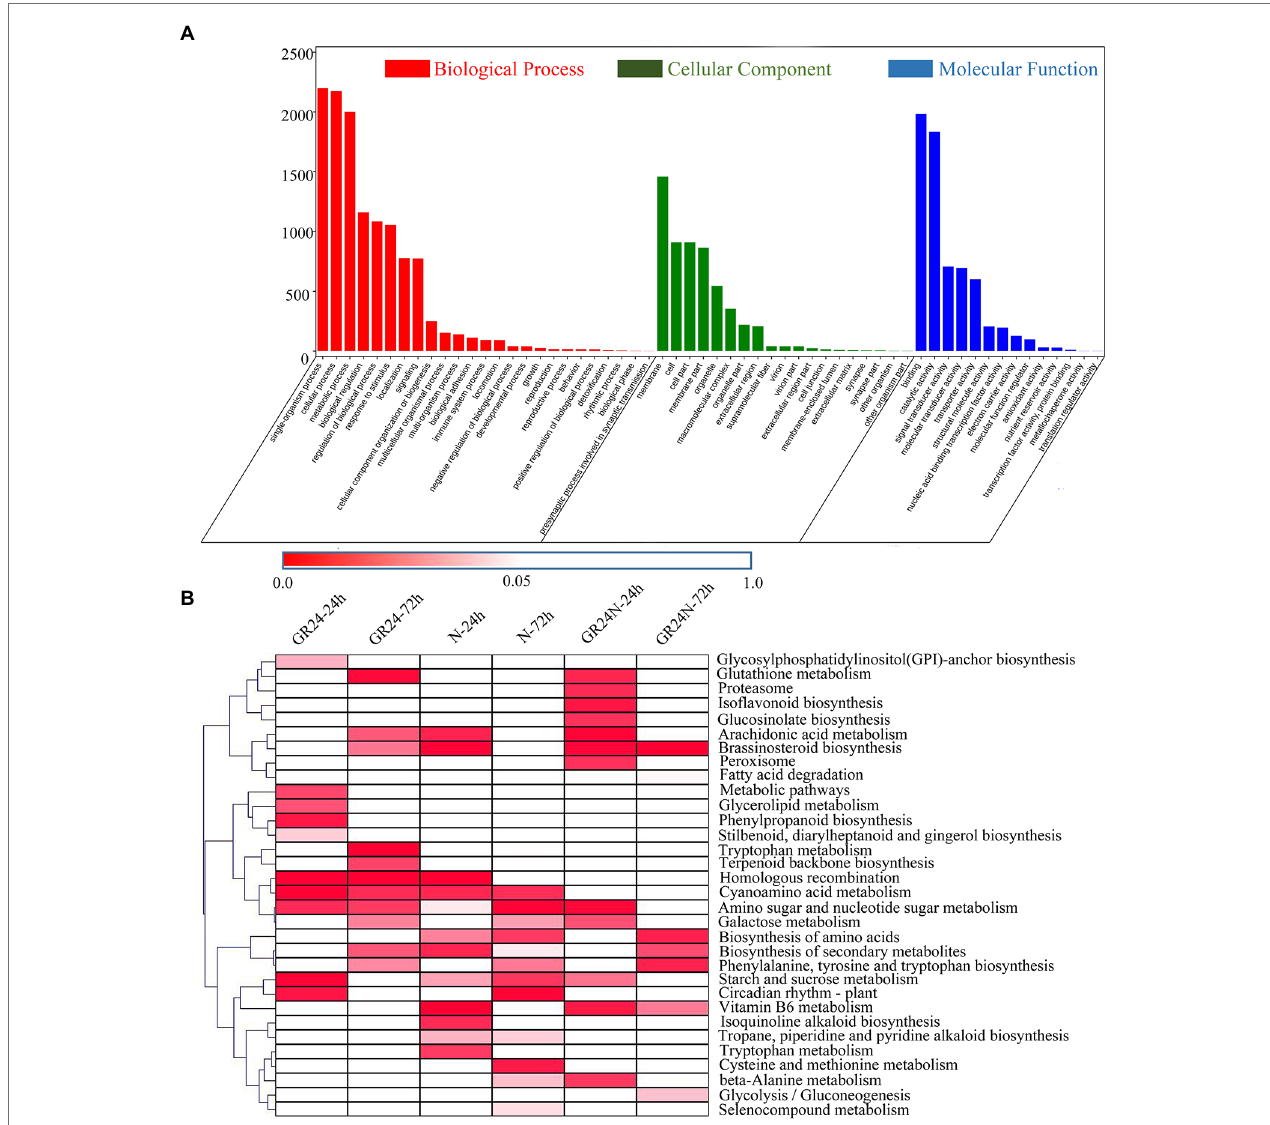
FIGURE 2 | Enrichment analysis of the DEGs in different comparisons. (A) GO enrichment analysis of all the DEGs based on three GO terms: biological process, cellular component, and molecular function. (B) KEGG enrichment analysis of the DEGs in the six comparisons. The significant values of p of each KEGG term under different treatments were shown by a